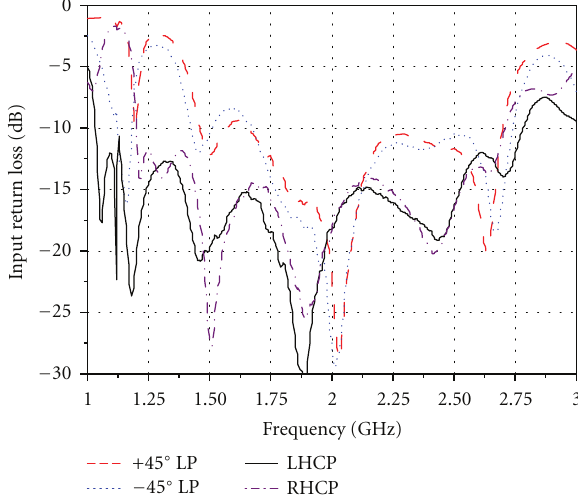
Figure 10: Measured return loss of the BPCDE PR prototype versus polarization reconfigurations.